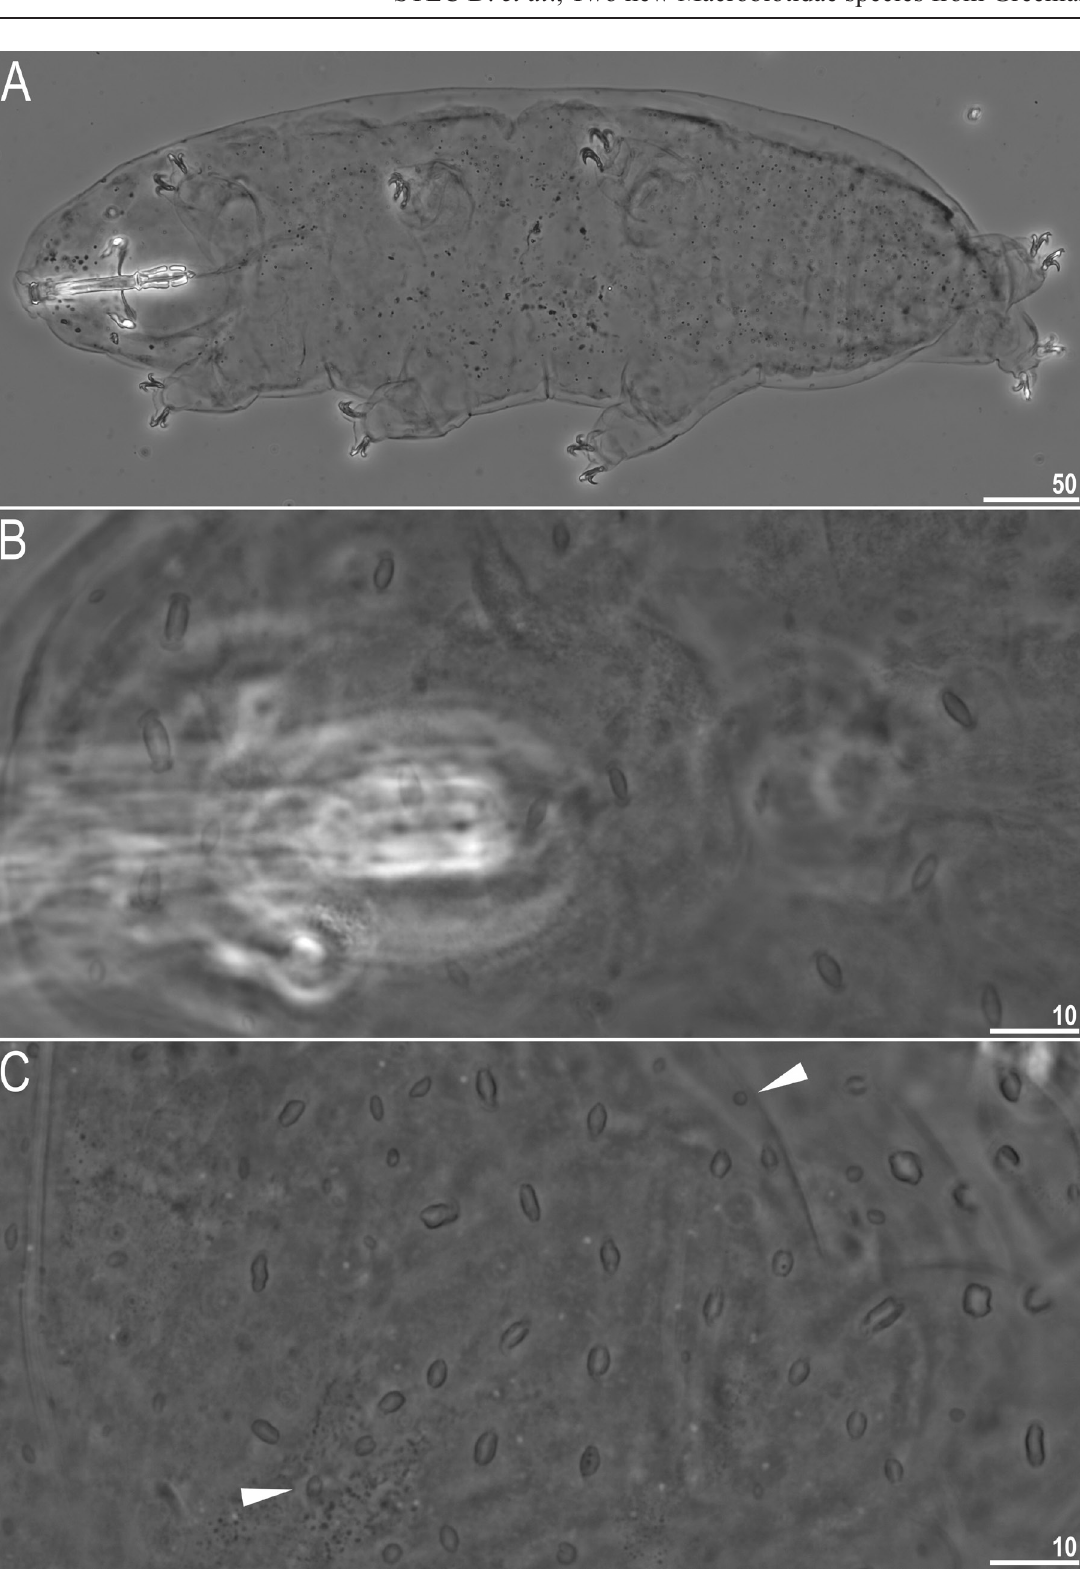
Fig. 1. Macrobiotus engbergi sp. nov. Habitus. A . Dorso-ventral projection (holotype, IZiBB, slide GL.052.22, Hoyer’s medium, PCM). B – C . Cuticular pores on the dorso-cephalic and dorso-caudal part of the body seen in PCM, respectively. Arrowheads indicate small oval pores. Scale bars in